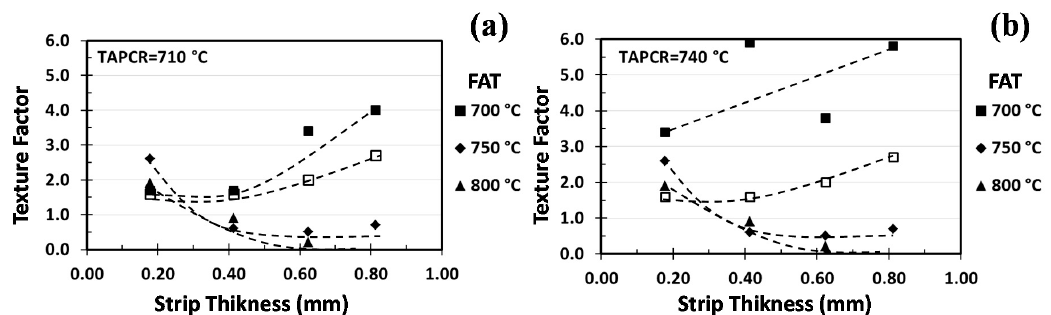
Figure 12. Effect of temperature of annealing prior to cold rolling (TAPCR) at: ( a ) 710 °C and ( b ) 740 °C, final annealing temperature (FAT) and strip thickness on texture factor. Data for material not annealed prior to cold rolling are indicated by open squares.